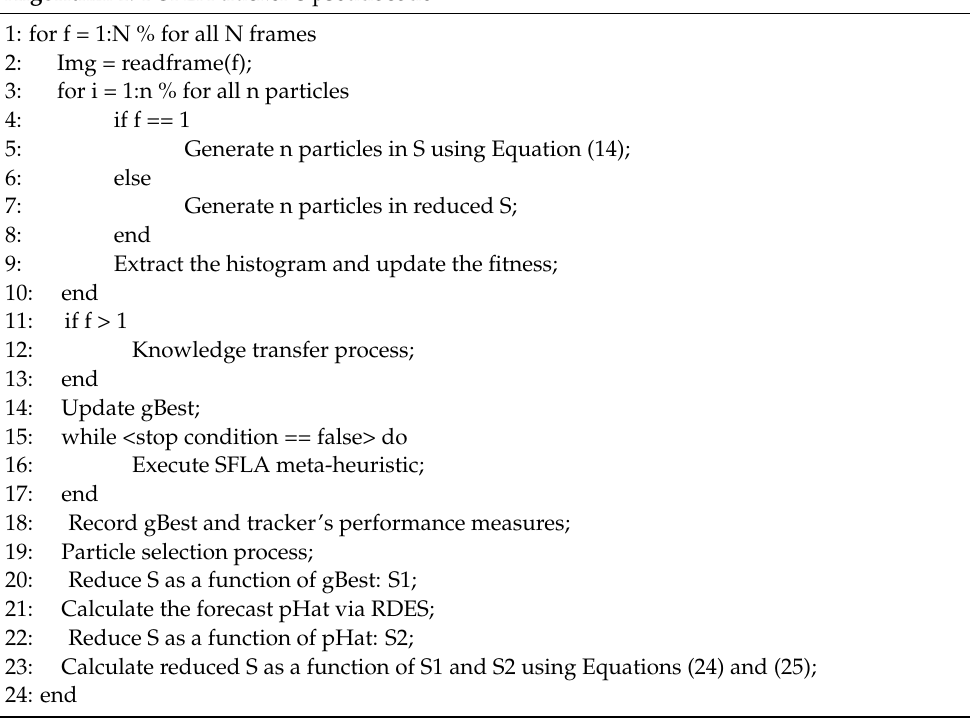
Algorithm 1. DSFLA tracker’s